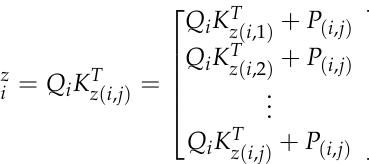
S of the ith input i